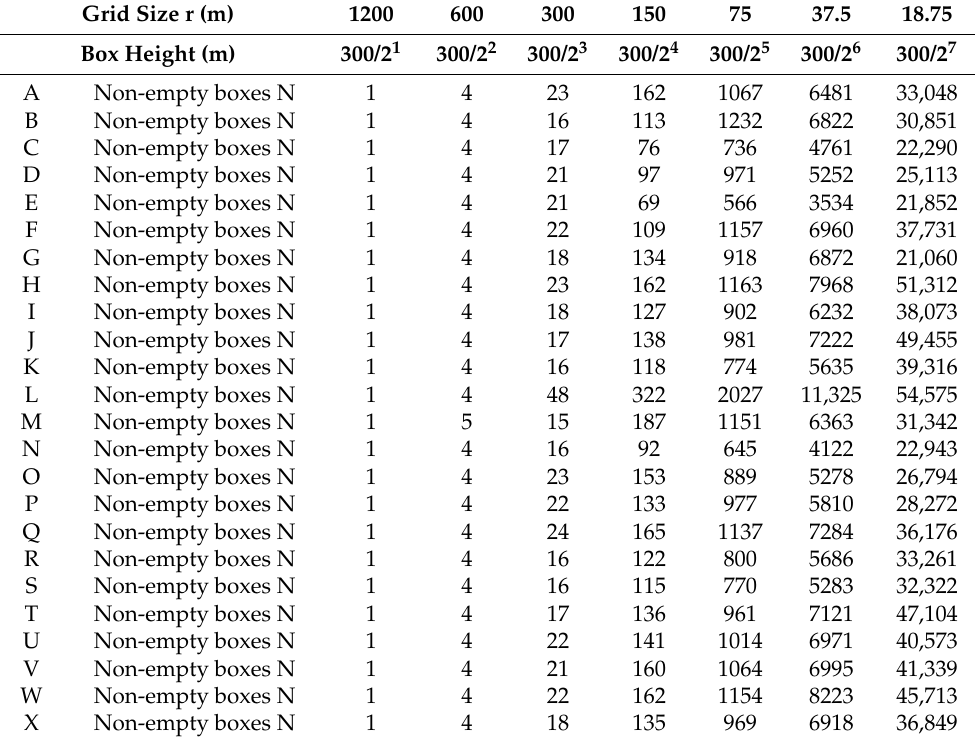
Table 4. Summary of results for various sizes of 3D boxes for the sub-research areas.